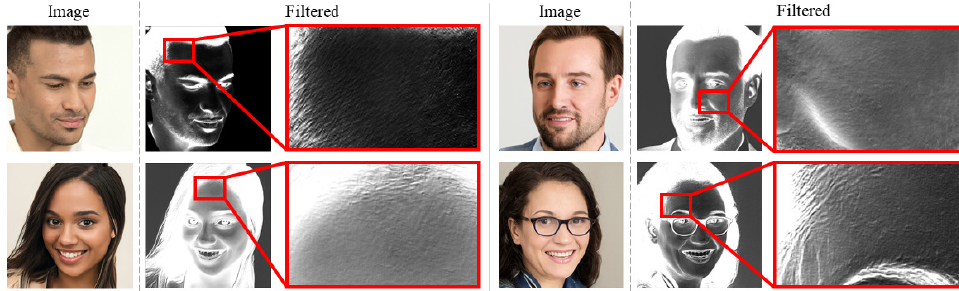
Figure 2. Example of image generated by StyleGAN properly filtered to highlight patterns resulting from the generative process.